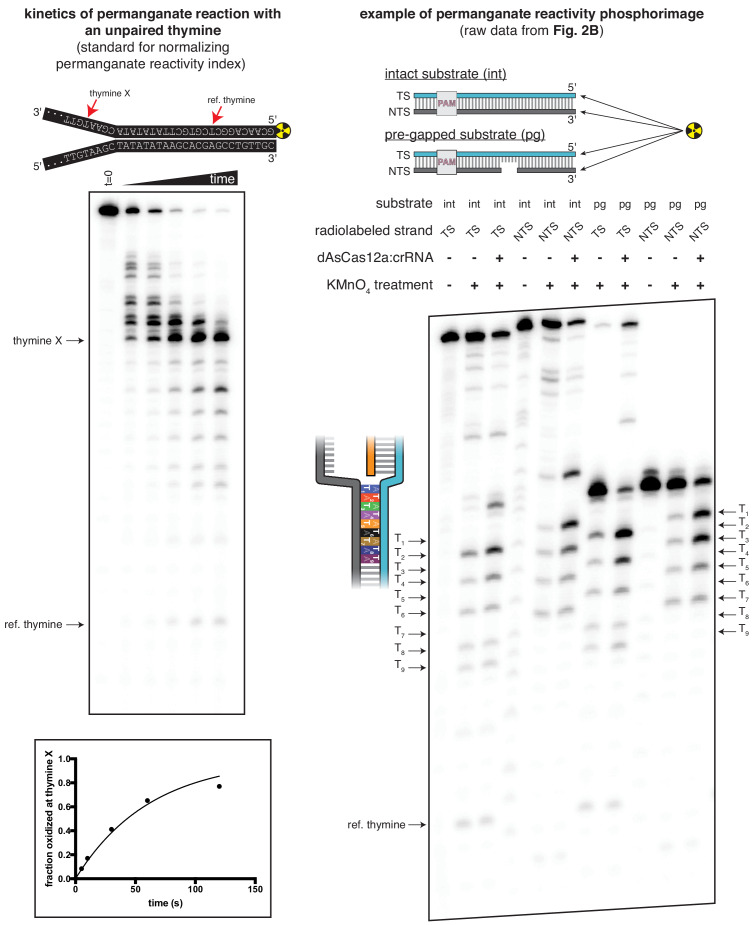
Translating raw phosphorimages into quantitative permanganate reactivity metrics.Left panel: Kinetics of permanganate reaction with an unpaired thymine. The depicted substrate was subject to the standard permanganate reaction protocol with quenching at 0, 5, 10, 30, 60, and 120 seconds. Black arrows indicate chemical cleavage fragments that resulted from oxidation of the annotated thymine. ‘Fraction oxidized at thymine X,’ plotted in the graph at the bottom, was determined as described in Materials and methods and is equivalent to the variable pi. The phosphorimage and graph shown are from a single representative replicate (n = 3). Data were fit to an exponential decay (y = (y0-plateau)*exp(-k*x)+plateau), with y0 constrained to 0 and the plateau value constrained to 1. The value of k was determined to be 0.998 min−1 ±0.027 (SD) (n = 3), which, when corrected to the reference thymine, yielded the value of kss,corr=0.79 min−1 that was used for normalization of the permanganate reactivity index in all other permanganate experiments. Right panel: Raw phosphorimage of quantified data presented in Figure 2B. Black arrows indicate chemical cleavage fragments that resulted from oxidation of the annotated thymine. The method to determine the 'permanganate reactivity index' and 'fraction oxidized' metrics from a raw phosphorimage is described in Materials and methods.